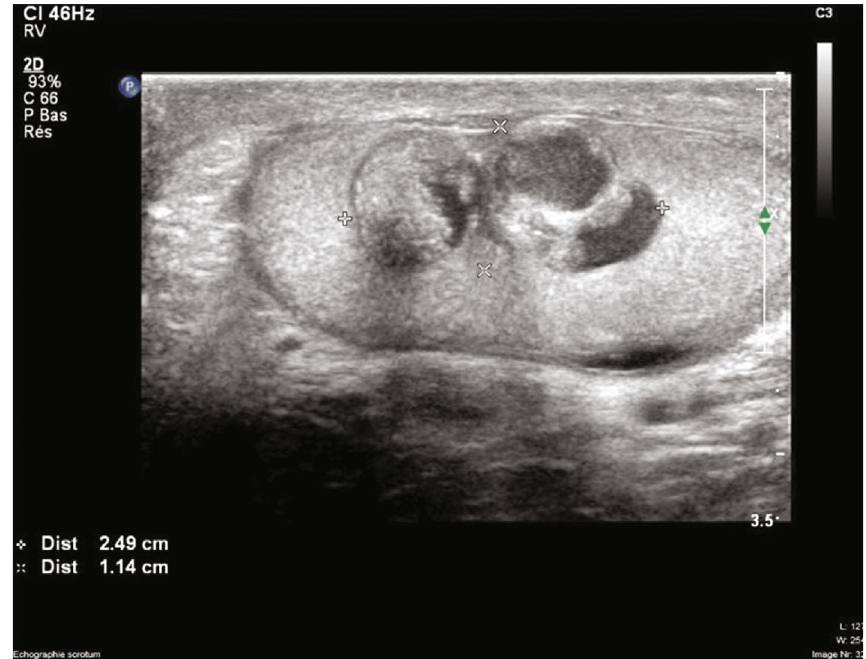
Figure 1: Ultrasound features: heterogenous, hypoechogenic, and cystic tumor of 20mm.